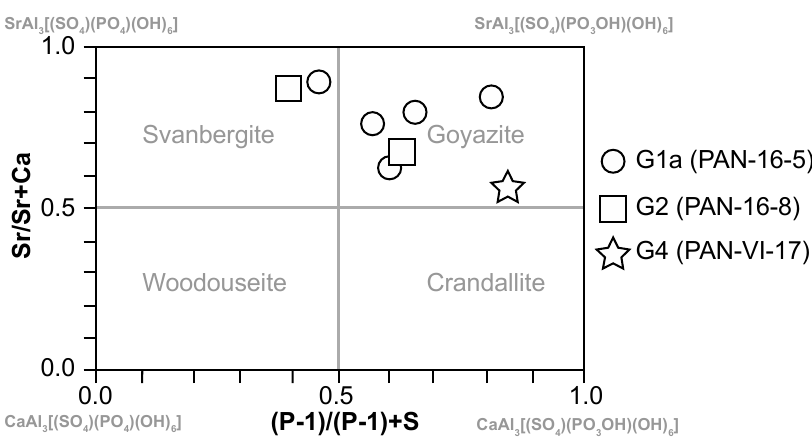
Figure 21. Characterization of the alumina-phosphate-sulfates (APS) associated with apatite in Panasqueira granites (following Salama 2014). The quadrilateral S/Sr + Ca versus (P-1)/(P-1) + S diagram of the beudantite and crandallite group minerals shows that Panasqueira APS is a svanbergite/goyazite solid solution (with minor woodhouseite and crandallite components).